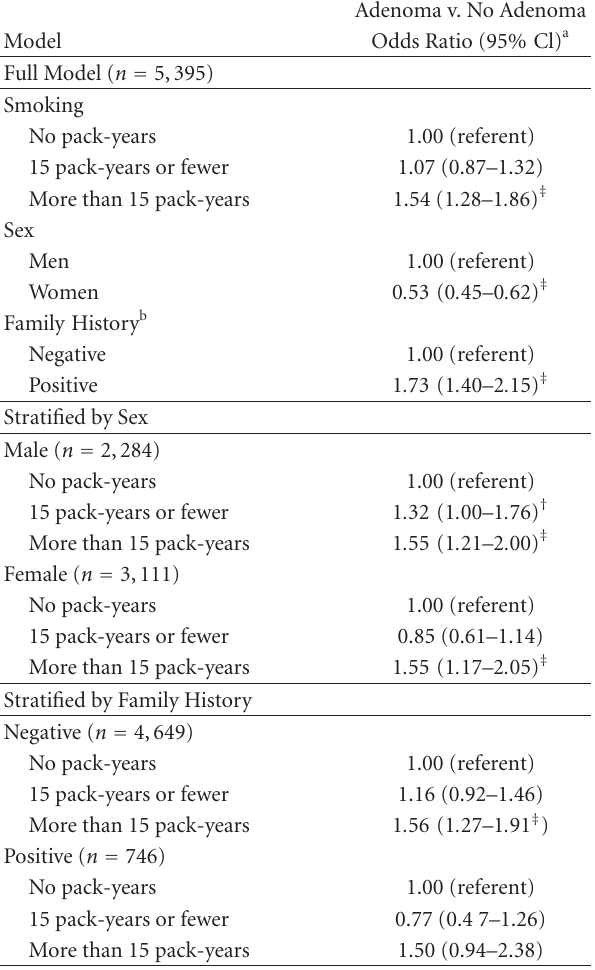
Table 4: Stratified logistic regression models of smoking and adenoma occurrence among individuals undergoing screening colonoscopy in the New Hampshire colonscopy Registry from 2004–2006.